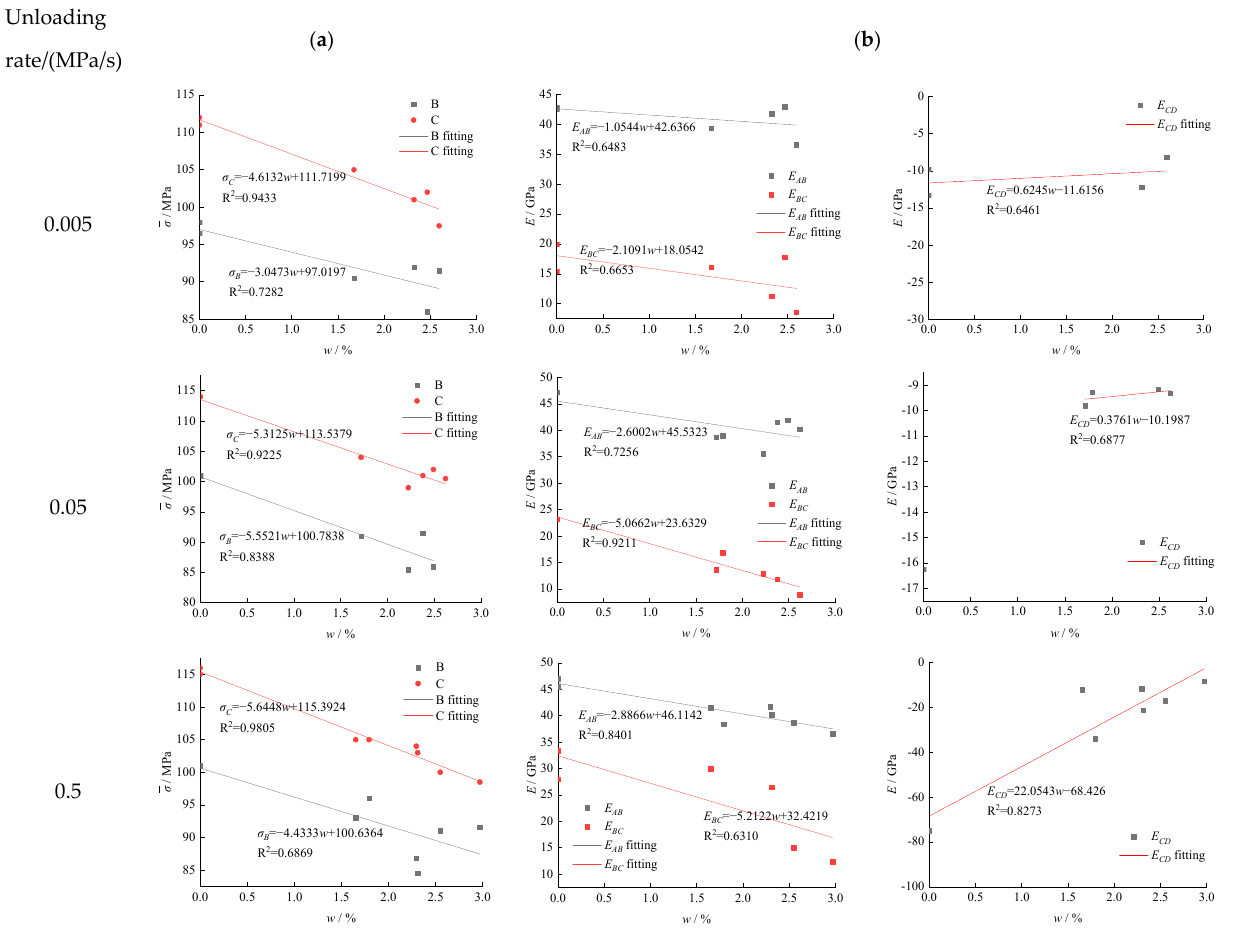
Figure 9. The mechanical turning points of the specimen under constant axial pressure, an unloading confining pressure, and the strength variance rate corresponding to the water content. ( a ) Mechanical turning point. ( b ) Strength variance